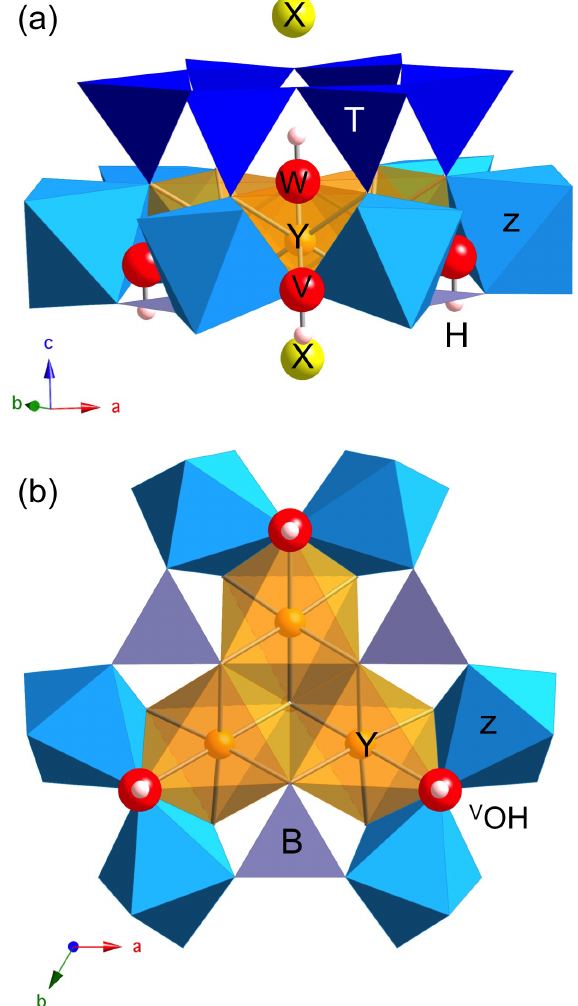
Figure 1. Dravite cluster displaying the main sites exerting a control on the OH stretching frequencies: lateral view (a) and projection along the [001] direction (b) . The three symmetrically equivalent V (OH) groups are coordinated to one Y and two Z sites, whereas the W (OH) group is coordinated to three Y sites. The purple grey triangles at the base of the Z and Y sites correspond to BO 3 units. O and H atoms belonging to OH groups are represented as red and white spheres, respectively (radii are only